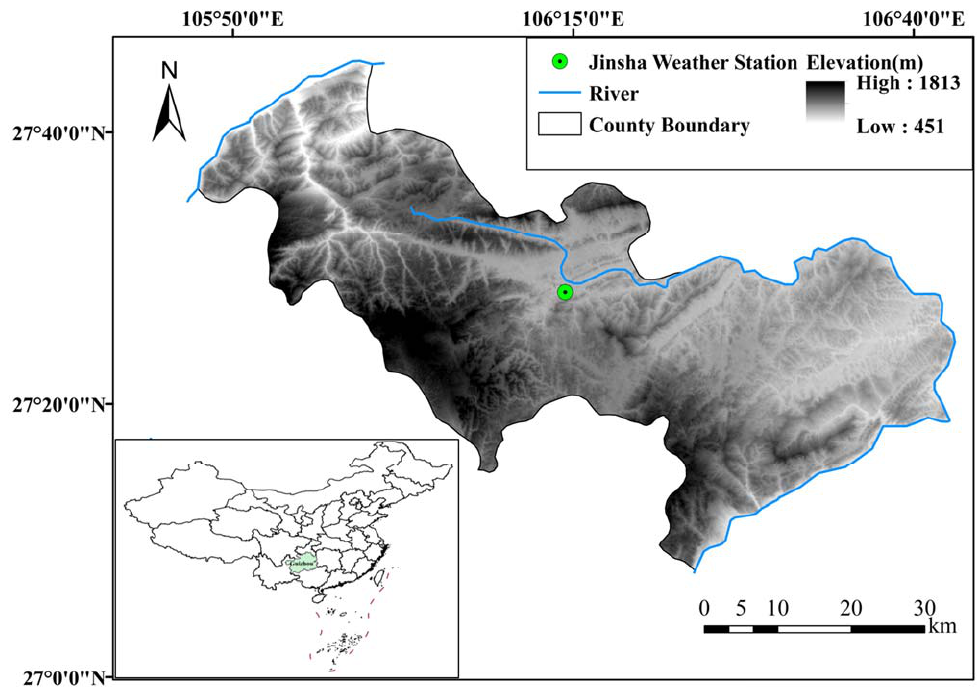
Figure 1. Location of Jinsha weather station.